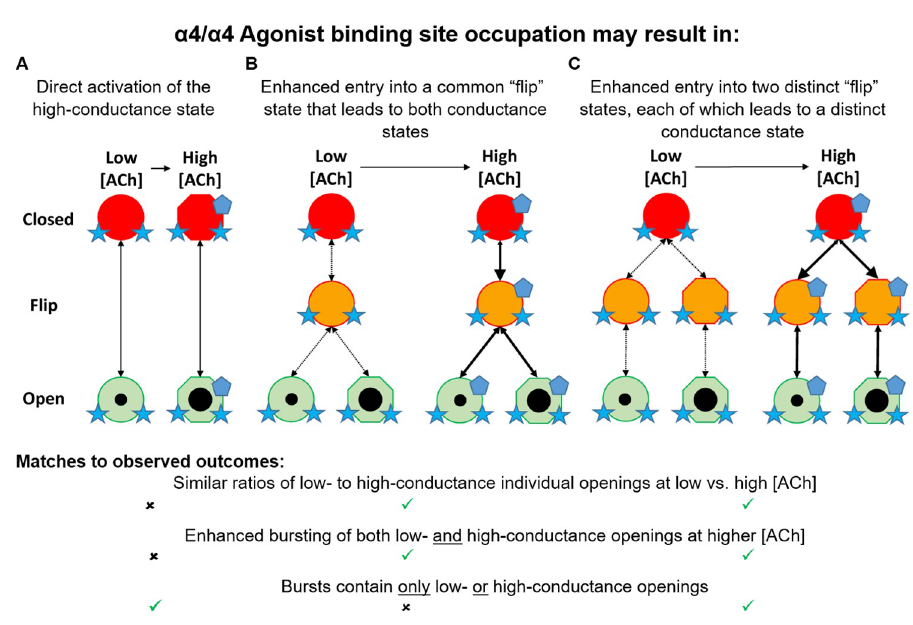
Fig 12. Comparison of mechanisms considered to explain the observed functional effects of ACh binding at the α 4(+)/(-) α 4agonist binding site within LS-isoform α 4 β 2-nAChR. In all panels, red shapes denote receptors in a closed state while bound by ACh. Intermediate “flip” states (also closed) are represented by orange shapes, while open states are indicated with green shapes (low- and high-conductance open states are shown as small and large black dots, respectively, within these green shapes). Where each model suggests emergence of a distinctly-different pathway, shapes change from circles to octagons. Receptor transitions between states are indicated with double-ended arrows, and bolder lines indicate increased probability of that transition occurring. ACh bound to the pair of canonical, high- affinity, α 4(+)/(-) β 2 agonist binding pockets is symbolized by blue stars, and a blue pentagon represents ACh bound to the low-affinity α 4(+)/(-) α 4 agonist binding site uniquely found within LS-isoform α 4 β 2-nAChR. A) Since